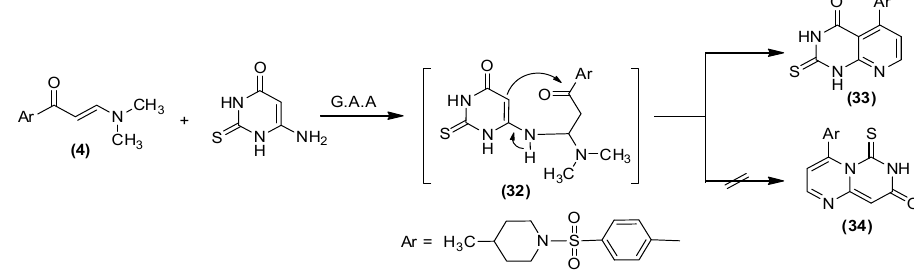
Figure 1. The IC 50 values expressed in ( μ M) of the target compounds against the MCF-7, HCT-116, and HepG-2 tumor